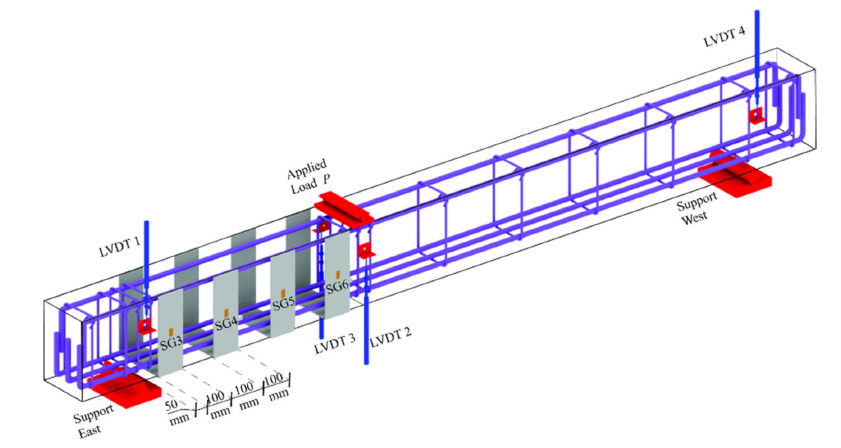
Figure 1. Test setup adopted.